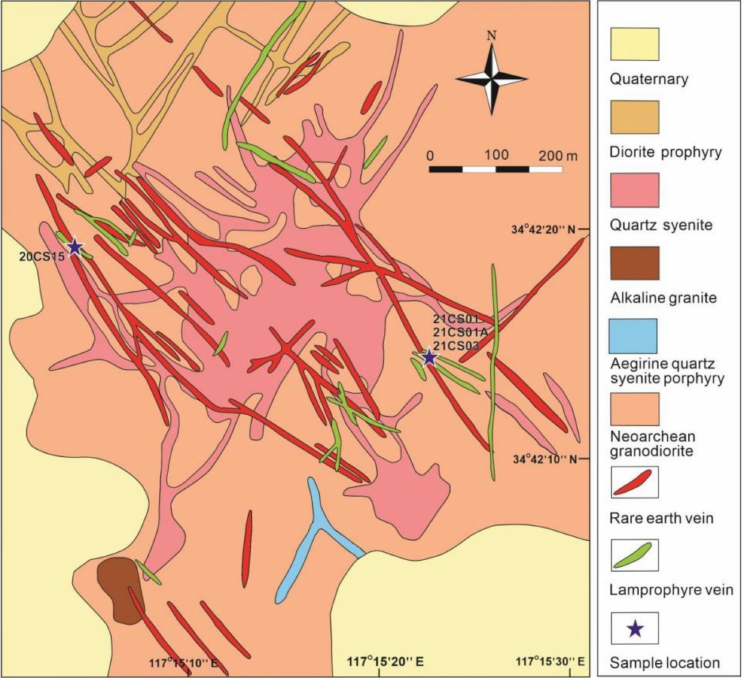
Figure 2. Geological sketch map of the Weishan REE deposit